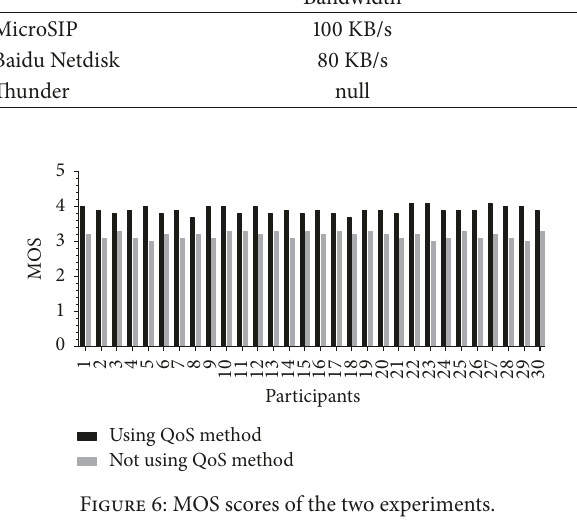
Figure 6: MOS scores of the two experiments.